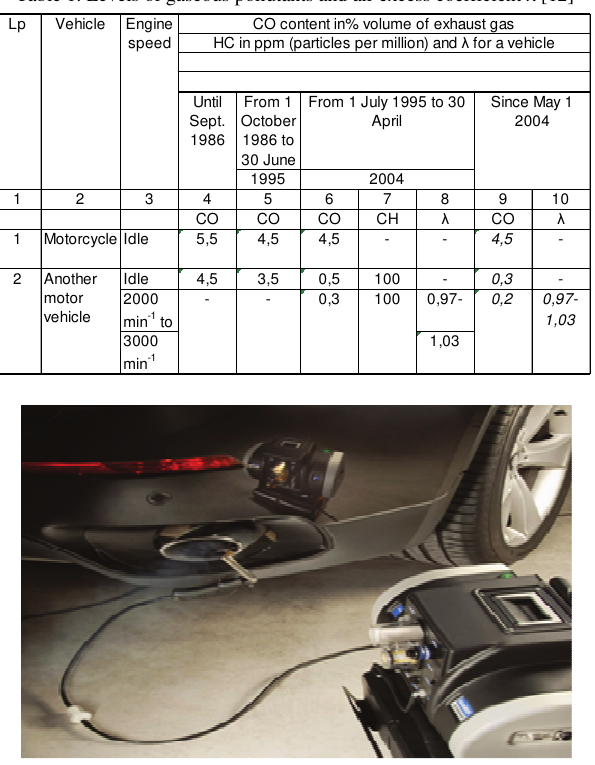
Fig. 6. Emission control [10]